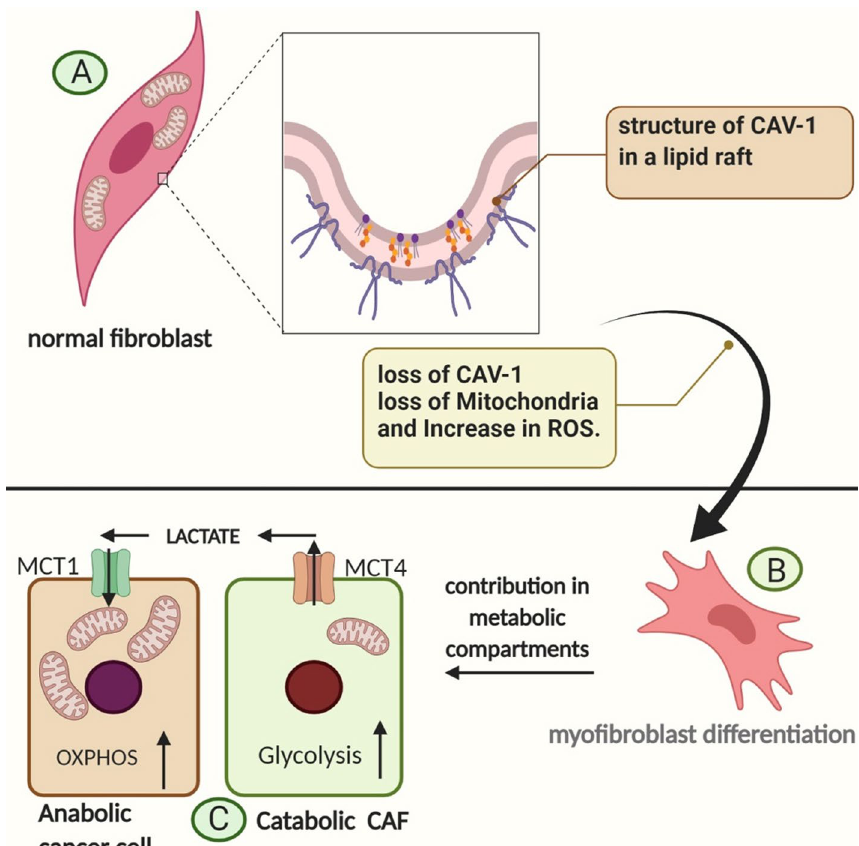
Fig. 2 Loss of CAV-1 and myofibroblast differentiation. a In the cell membrane of normal fibroblasts, many CAV-1 molecules are located in the lipid raft. These cells mainly depend on the OXPHOS pathway for energy production due to the high number of mitochondria. b Exposure to ROS in the TME increases autophagy and loss of CAV-1. Lack of mitochondria shifts metabolism towards glycolysis, and lactate generation drives myofibroblast differentiation. c Catabolic CAFs tend to couple with anabolic cancer cells in a metabolic compartment. Anabolic cancer cells have mitochondrial reach cytoplasm and deeply depend on OXPHOS. This phenomenon is known as “the reverse Warburg effect.” CAV Caveolin, MCT monocarboxylate transporter, OXPHOS oxidation